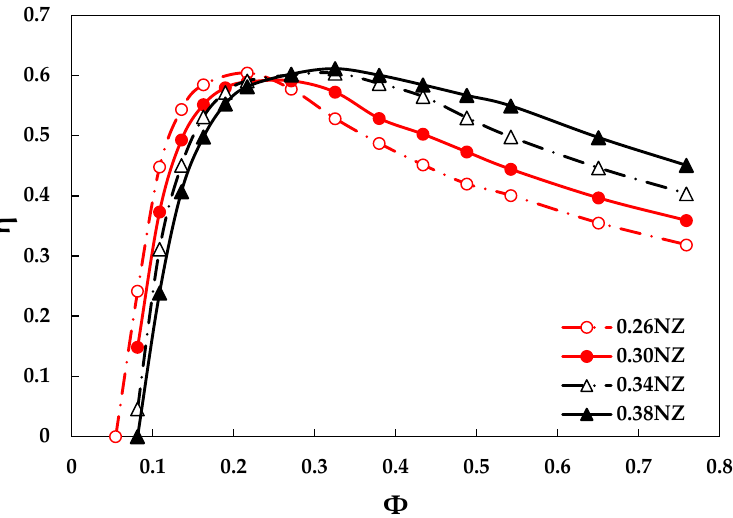
Figure 6. Effect of rotational speed and number of rotor blades on the turbine performance with 3 mm blade thickness.